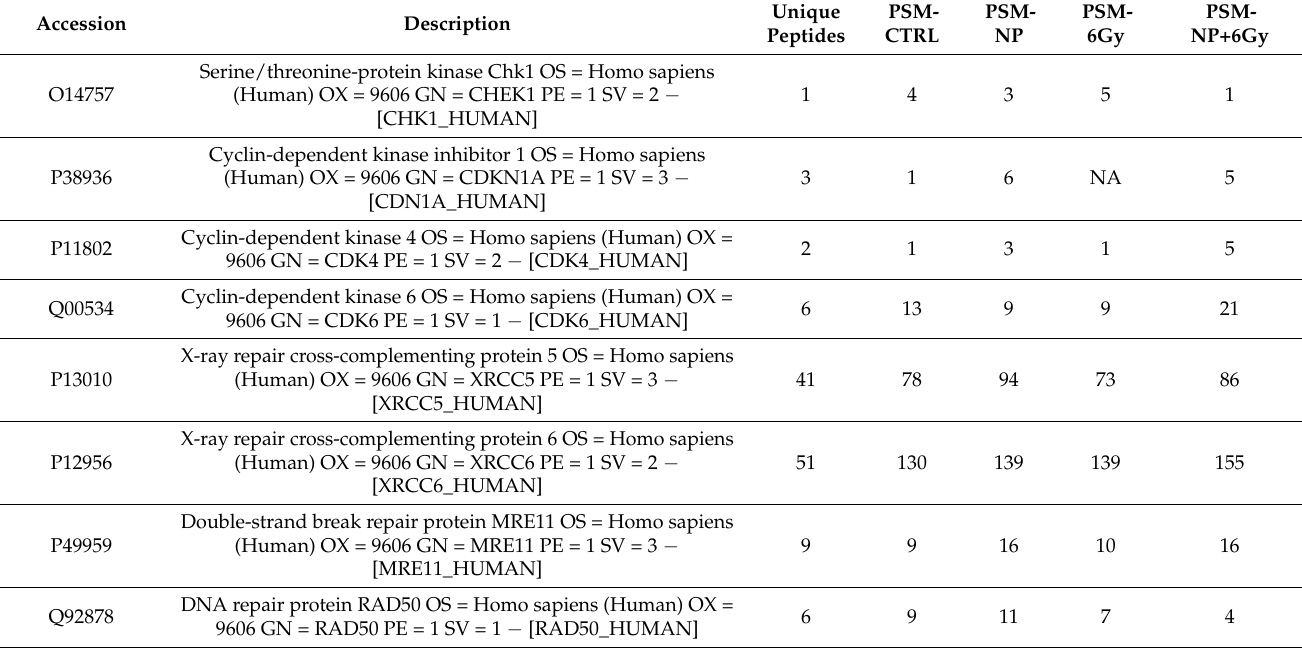
Table 1. Number of unique peptides and PSMs distributions for proteins involved in DNA damage response identified by mass spectrometry